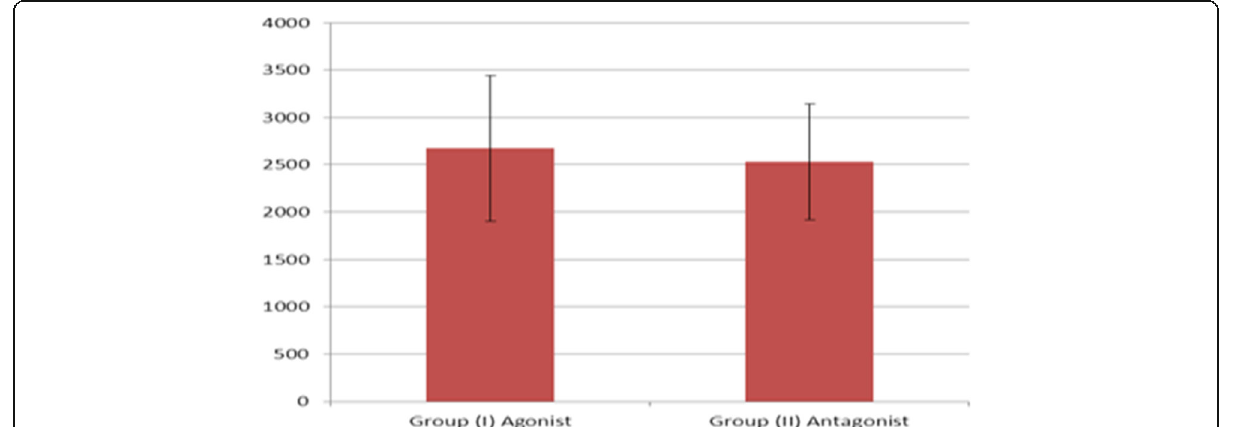
Fig. 3 Box plots representing the median and IQR for the levels of E2 concentrations in the day of hCG in both groups